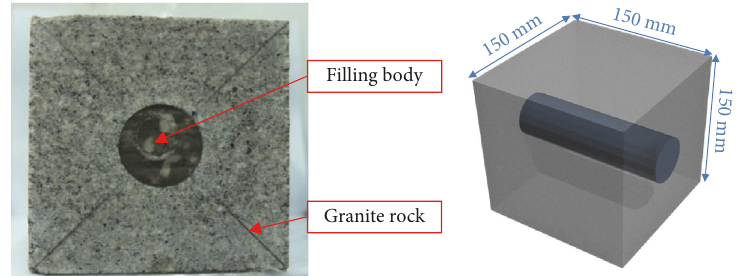
Figure 1: Tunnel